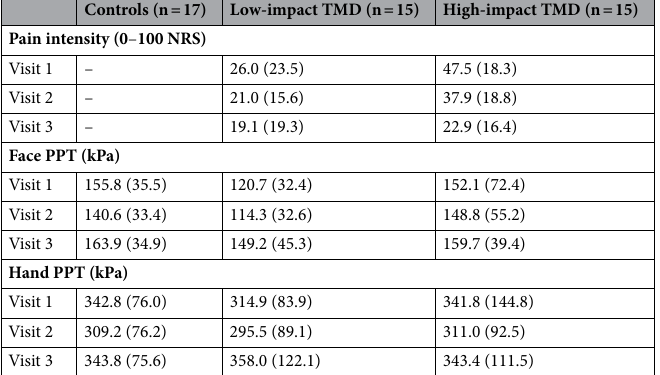
Table 2. Repeated clinical and experimental pain measures for each visit. Results are presented as mean and standard deviation. NRS numerical rating scale, PPT pressure pain thresholds, TMD temporomandibular disorders.